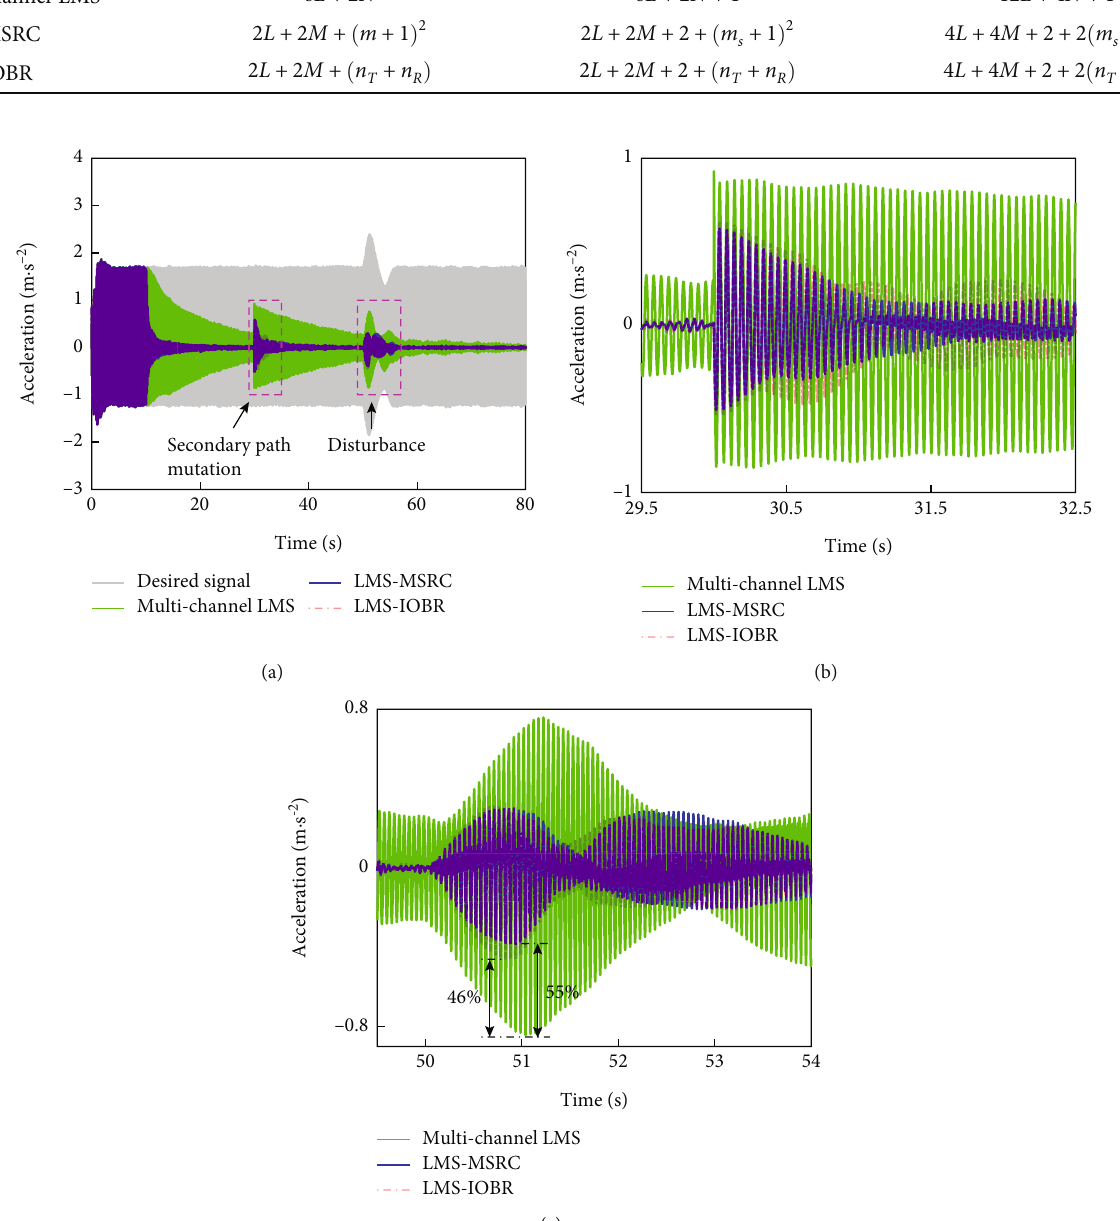
Figure 6: Comparison of acceleration response with 3 di ff erent helicopter ACSR methods. (a) Acceleration response. (b) Control process at secondary path mutation (29.5-32.5 s). (c) Control process at additional perturbation (49.5-54